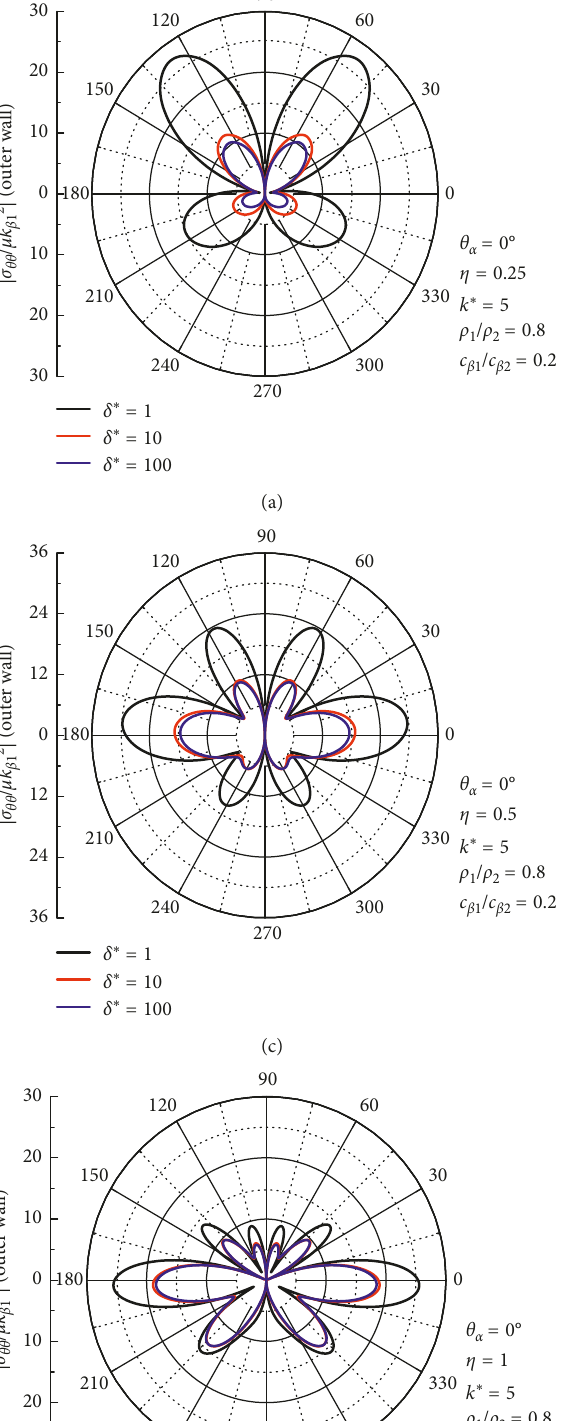
0 . 25, θ α (cid:29)